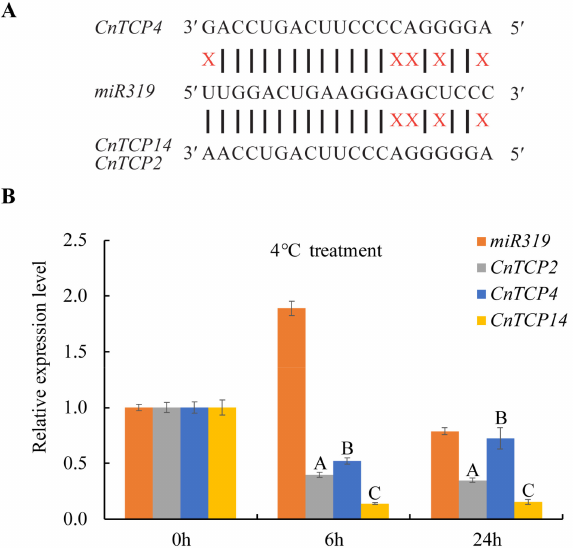
Figure 6. Mature miR319 and predicted target CnTCP expression in response to cold stress. ( A ) Pre- dicted CnTCP transcript targets of miR319 . ( B ) Expression levels of mature miR319 and its predicted targets CnTCP2/4/14 in two-month-old Chrysanthemum nankingense plants treated at 4 ◦ C for 0, 6, and 24 h. U6 and EF-1 α were used as the internal control in miR319 and CnTCP expression detection, respectively. Values are means ± SD. The different capital letters represent significant differences at p < 0.01 according to the Duncan’s